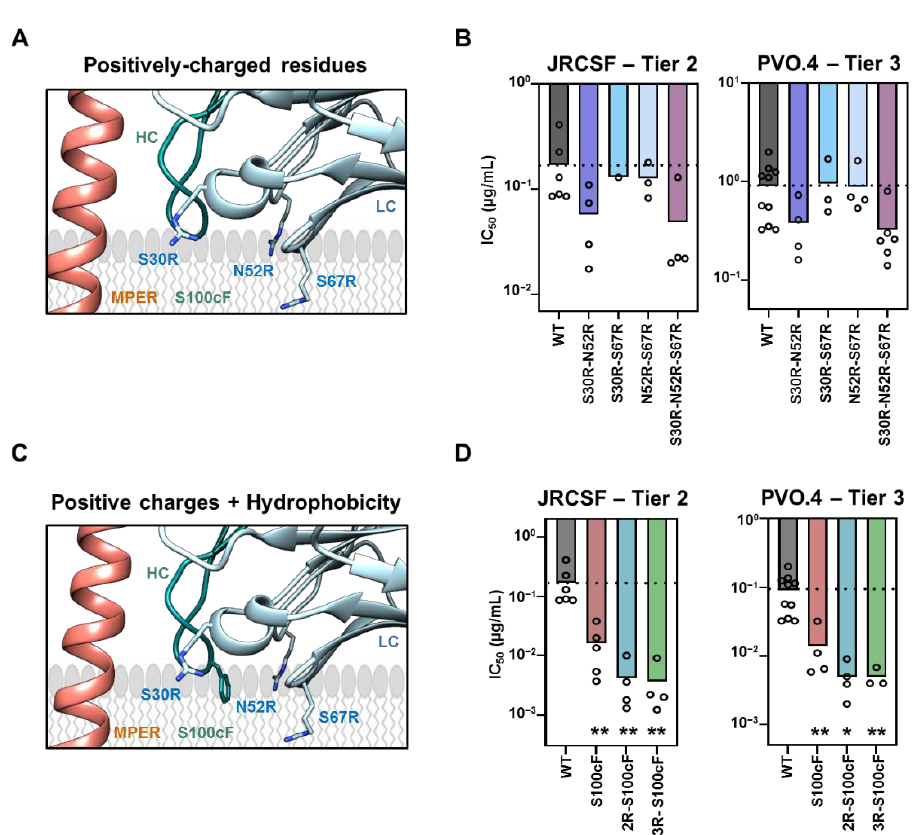
Figure 2. Contribution of charge and hydrophobicity-at-interface in the neutralization of 10E8 . ( A ) Cartoon representation depicting the position of the three Arg-s at the membrane-facing surface of the antibody (blue) with respect to the membrane (gray) and its epitope peptide (orange). ( B ) IC 50 comparison of 10E8 Fab variants (different shades of blue) and 10E8-WT (dark gray) with double and triple combinations of Arg-s against JRCSF and PVO.4 PsV (mean values ± SD for a minimum of three experimental replicates). ( C ) Position of mutation S100cF (green) relative to the three Arg-s in 10E8-3R. Color code as in A. ( D ) Effect of adding the mutation S100cF in the neutralization potency of 10E8 (red), 10E8-2R (blue) and 10E8-3R (green). * and ** indicate significance compared to 10E8-WT ( p < 0.1 and p < 0.01, respectively) by ANOVA.